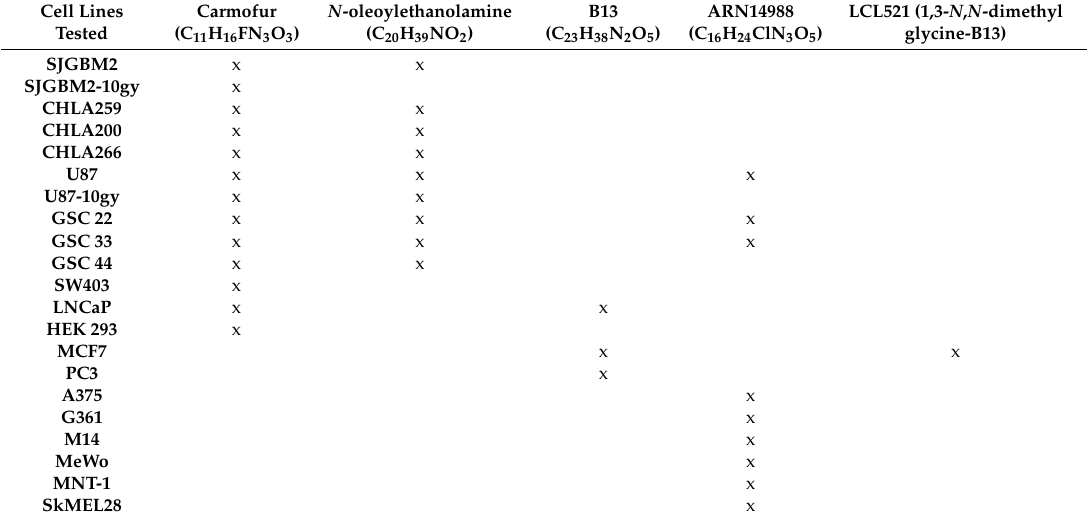
Table 1. Cell lines that were tested with various ASAH1 inhibitors are shown, including their chemical